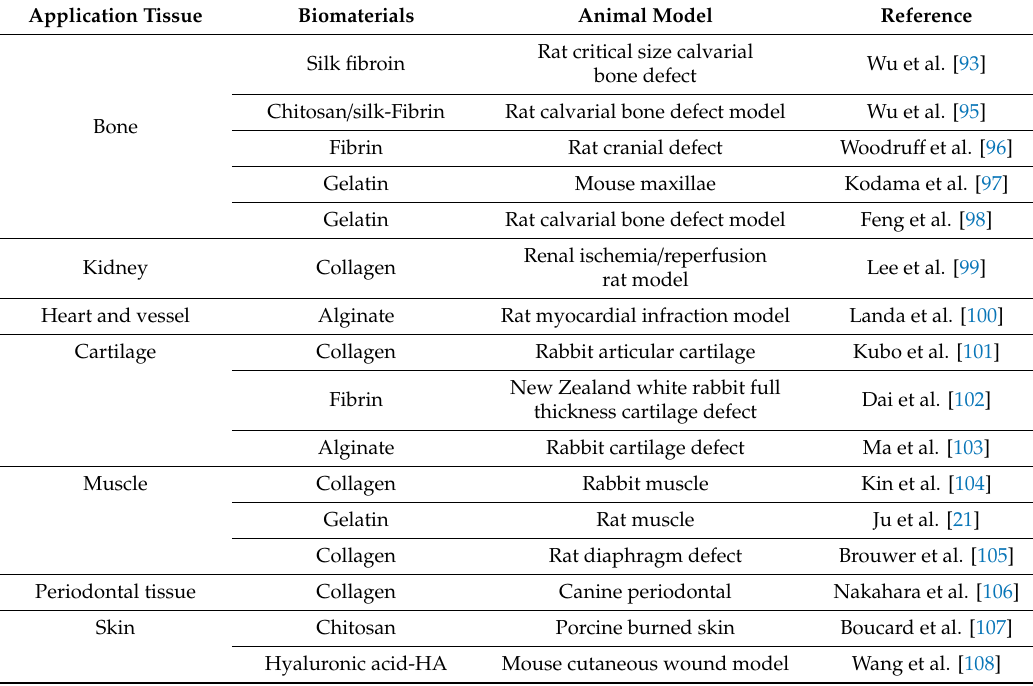
Table 2. Recent examples of natural polymer biomaterials used for in situ tissue regeneration.